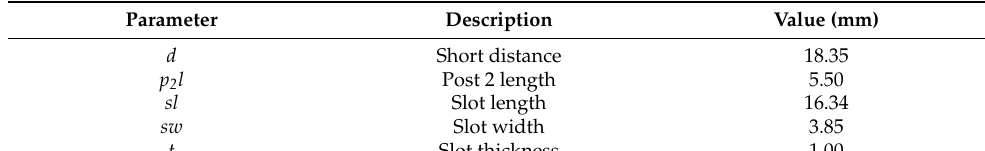
Figure 7. E-plane T-junction geometry. ( a ) Top view. ( b ) 3D view. Table 3. E-plane T-junction geometrical parameters.